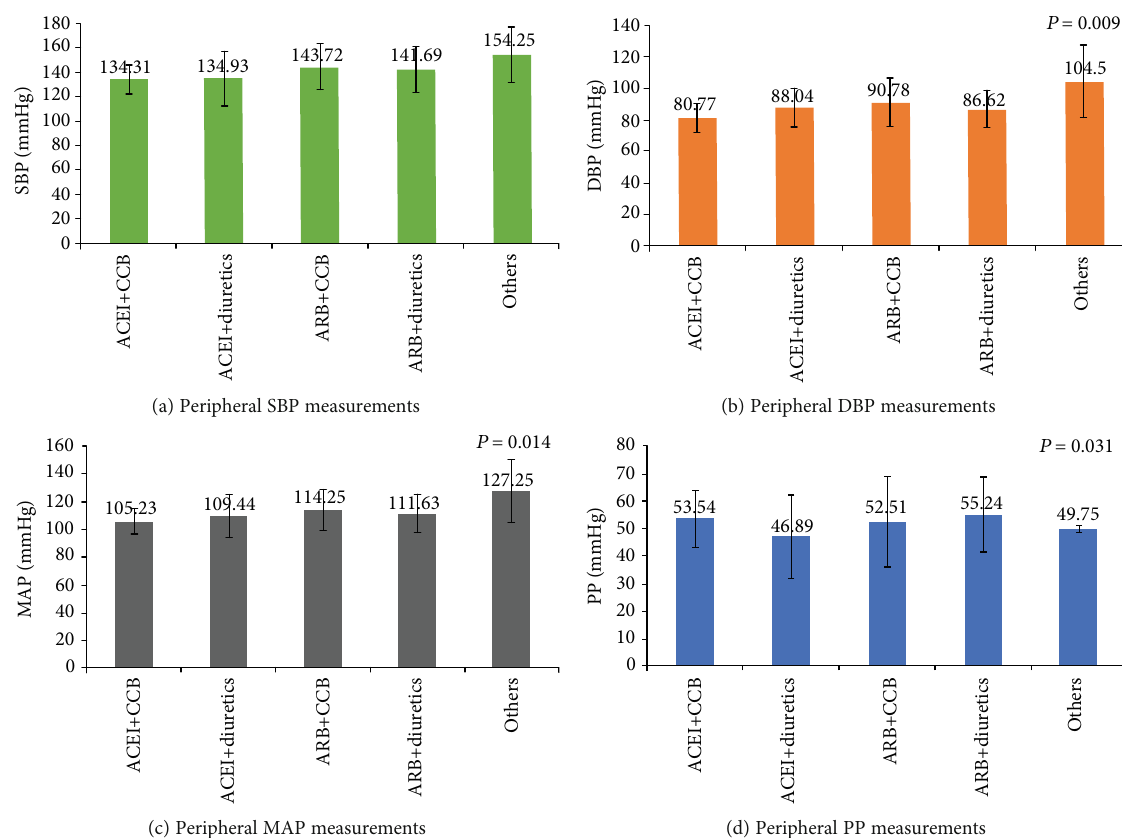
(d) Peripheral PP measurements Figure 1: Peripheral blood pressure measurements among various antihypertensive drug combinations. SBP: systolic blood pressure; DBP: diastolic blood pressure; MAP: mean arterial pressure; PP: pulse pressure. Table 4: Central blood pressure